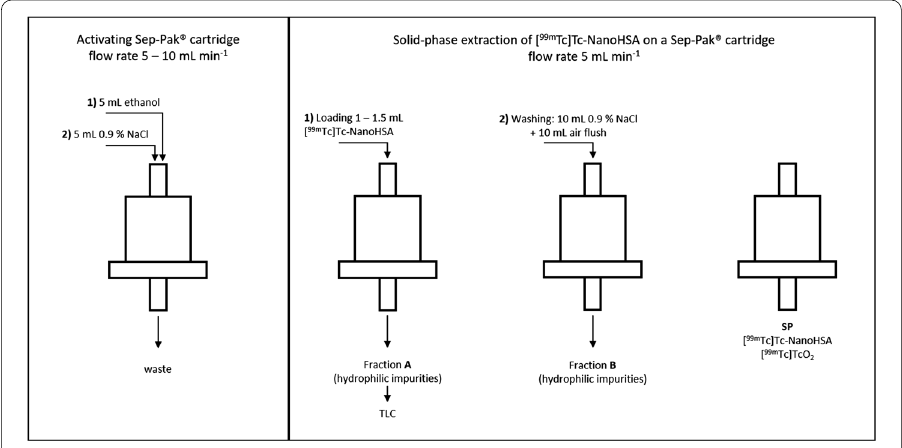
Fig. 1 Solid-phase extraction of NanoHSA using Sep-Pak ® cartridge. Colloidal [ 99m Tc]TcO 2 and [ 99m Tc] Tc-NanoHSA were retained on Sep-Pak ® cartridge enabling further TLC analysis of soluble hydrophilic impurities in fraction